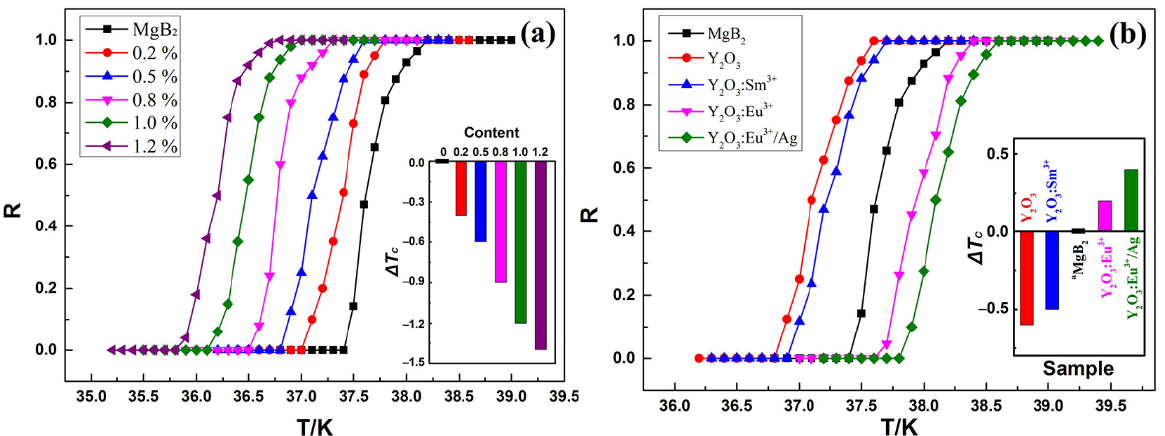
Figure 3. Normalized resistivity-temperature curves of a MgB 2 doped with ( a ) x % Y 2 O 3 ( x = 0, 0.2, 0.5, 0.8, 1.0, 1.2) and ( b ) 0.5% y ( y = 0, Y 2 O 3 , Y 2 O 3 :Sm 3+ , Y 2 O 3 :Eu 3+ , Y 2 O 3 :Eu 3+ /Ag). Insets: the values of Δ T c ( Δ T c = T c − T cpure ).